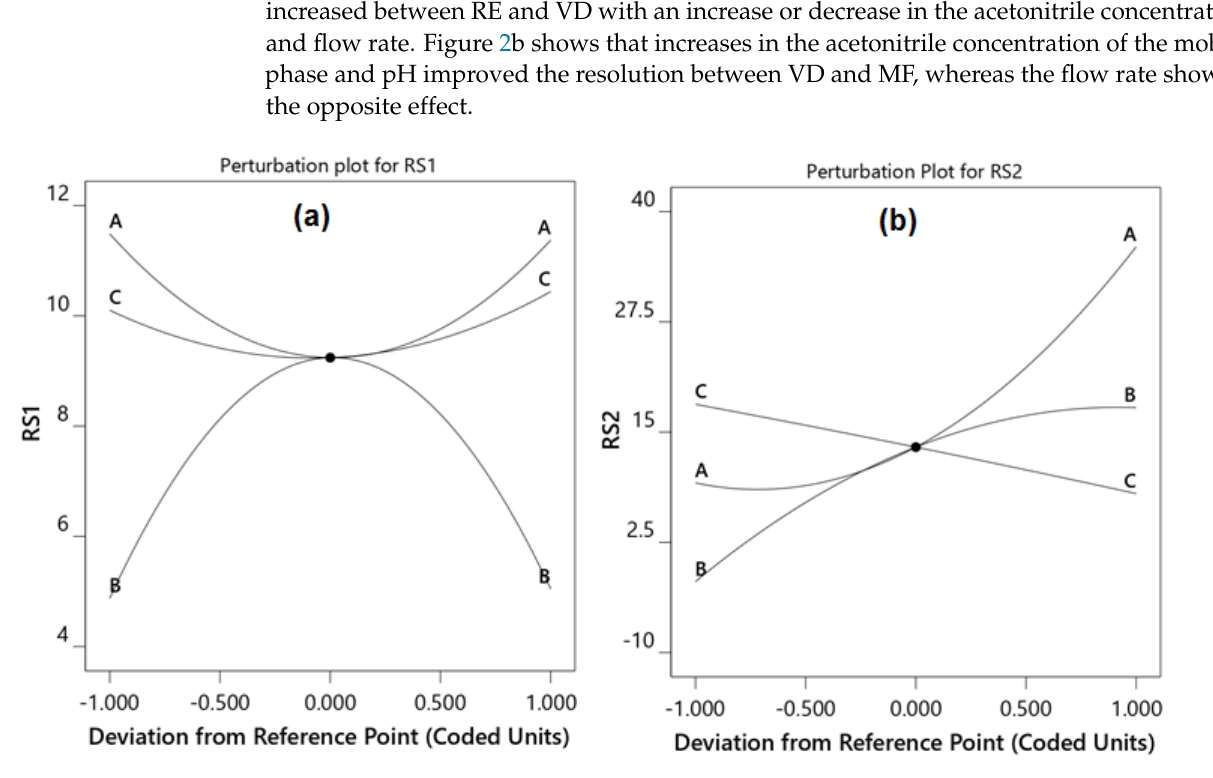
Figure 2. Perturbation plots showing the effect of the concentration of acetonitrile (A), pH of the mobile phase (B), and flow rate (C) on the resolutions of RE − VD ( a ) and VD − MF ( b ).